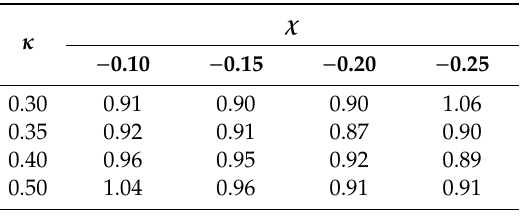
Figure 11. Ratios of the relative displacements of the central column of the underground structures controlled with a negative-stiffness amplification-system (NSAS)-based isolation system, and a conventional isolation system (CIS): ( a )   ,